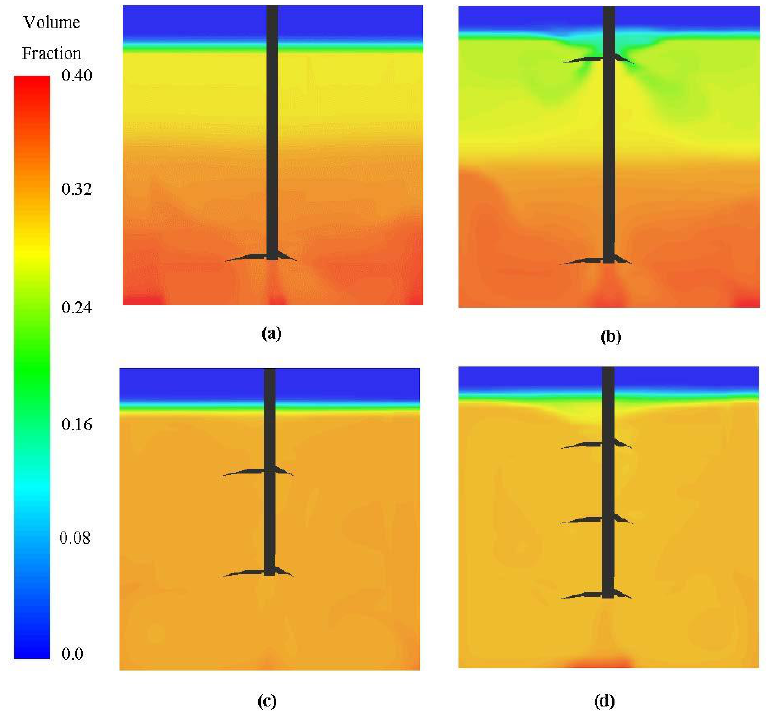
Figure 9. Concentration profiles in baffle-impeller plane for ( a ) Single impeller; ( b ) Twin-CT6; ( c ) Twin-CT3 and ( d )